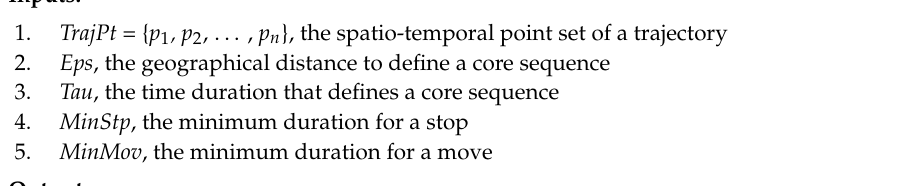
Algorithm SOC ( TrajPt, Eps, Tau, MinStp, MinMov ):